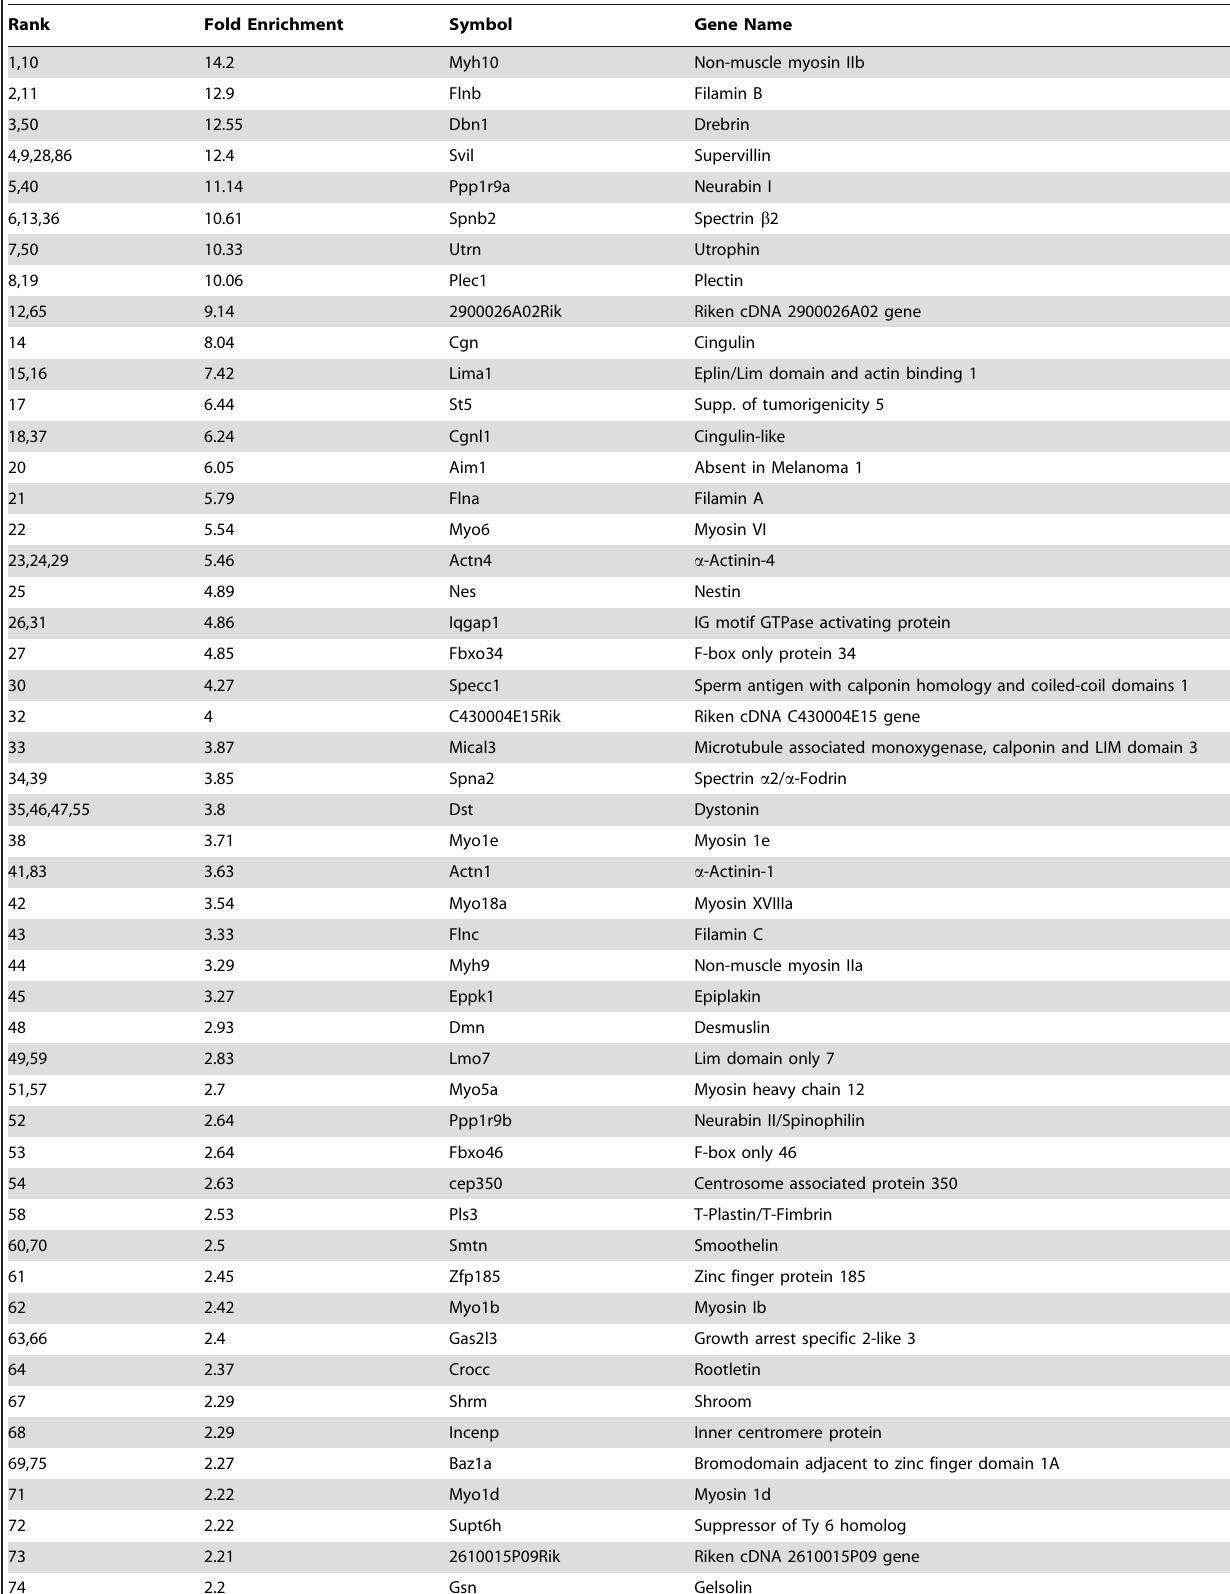
Rank Fold Enrichment